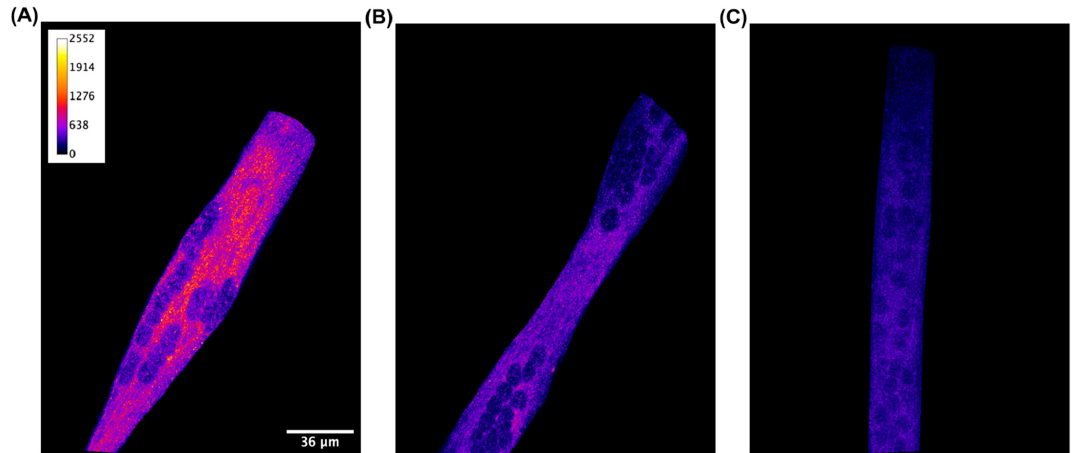
Figure 1. Qualitative detection with immunofluorescence staining of CB2 receptor in C2C12 skeletal muscle cells. Confocal image of a representative XY acquisition (60 × magnification) of ( A ) differentiated cells incubated with primary CB2 receptor antibody, ( B ) differentiated cells incubated with CB2 receptor antibody and its blocking peptide (1/1 ratio), and ( C ) differentiated cells incubated with secondary antibody alone. Scale bar: 36 μ m. Secondary antibody, anti-rabbit Alexa 200 Fluor 568, 1:1000. Images are presented in pseudocolor (LUT = fire) to better show the fluorescent intensity variations in the range 0–2552.